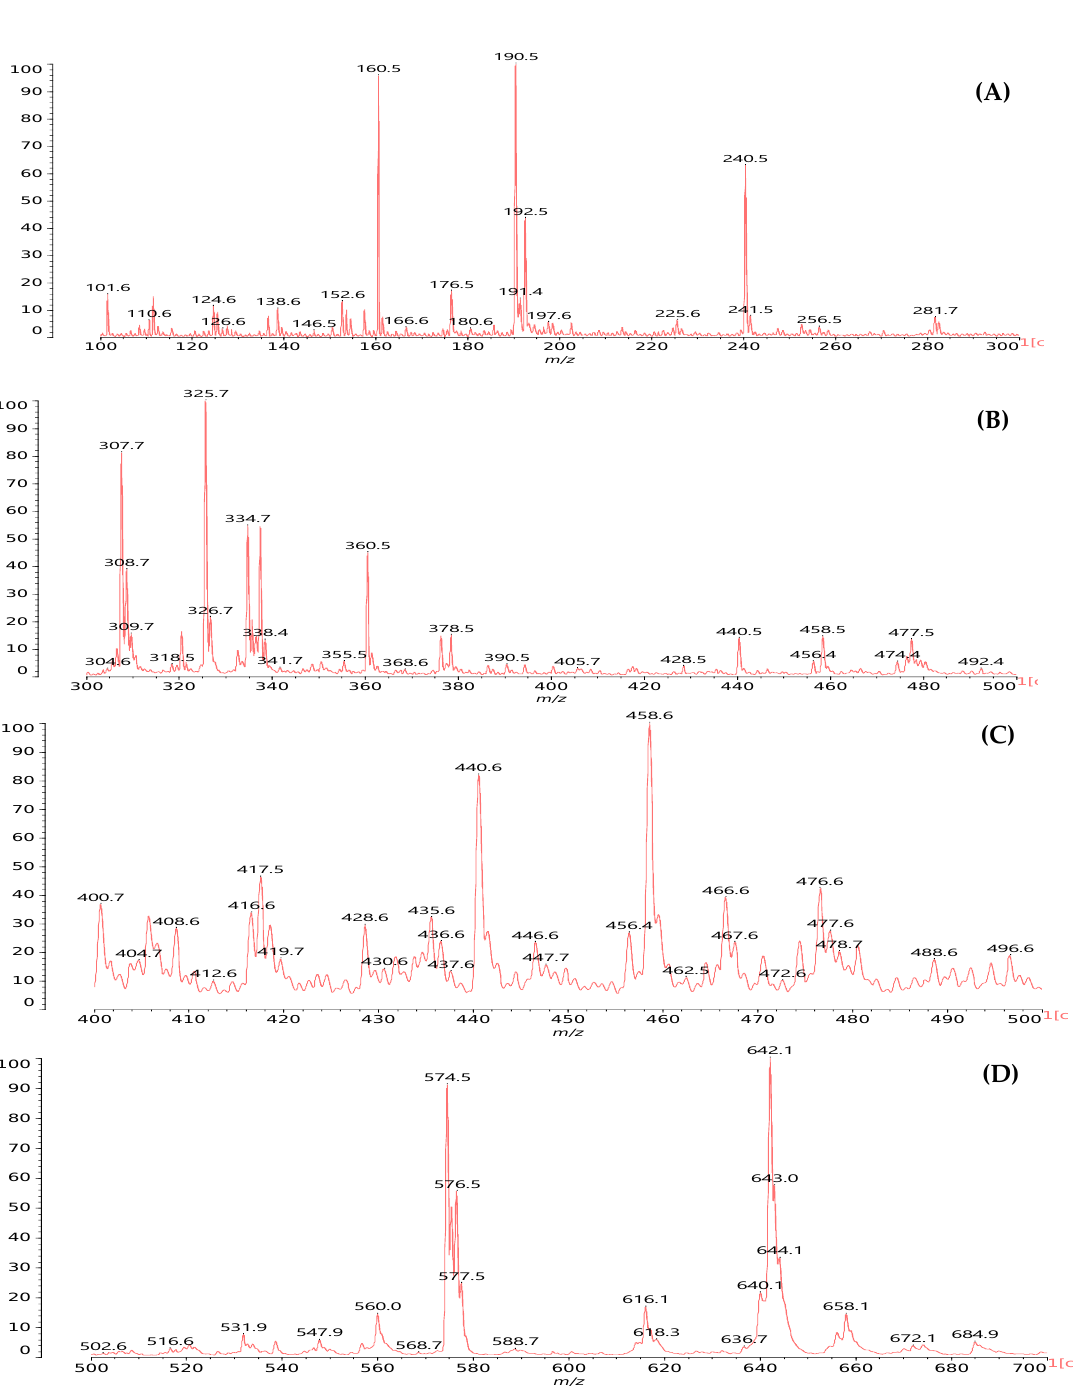
Figure 9. ( A – D ) MALDI ToF mass spectra of PFA+.